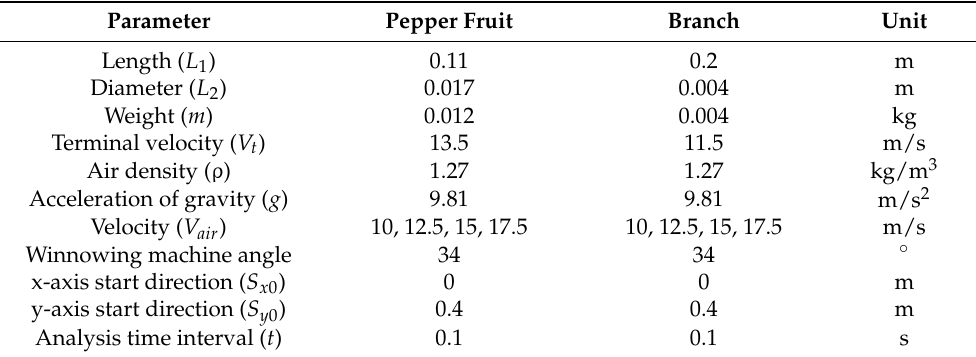
Figure 3. Force acting on the pepper fruit by winnowing machine velocity. Table 3. Calculation formula parameter for pepper fruit and branch in the blowing